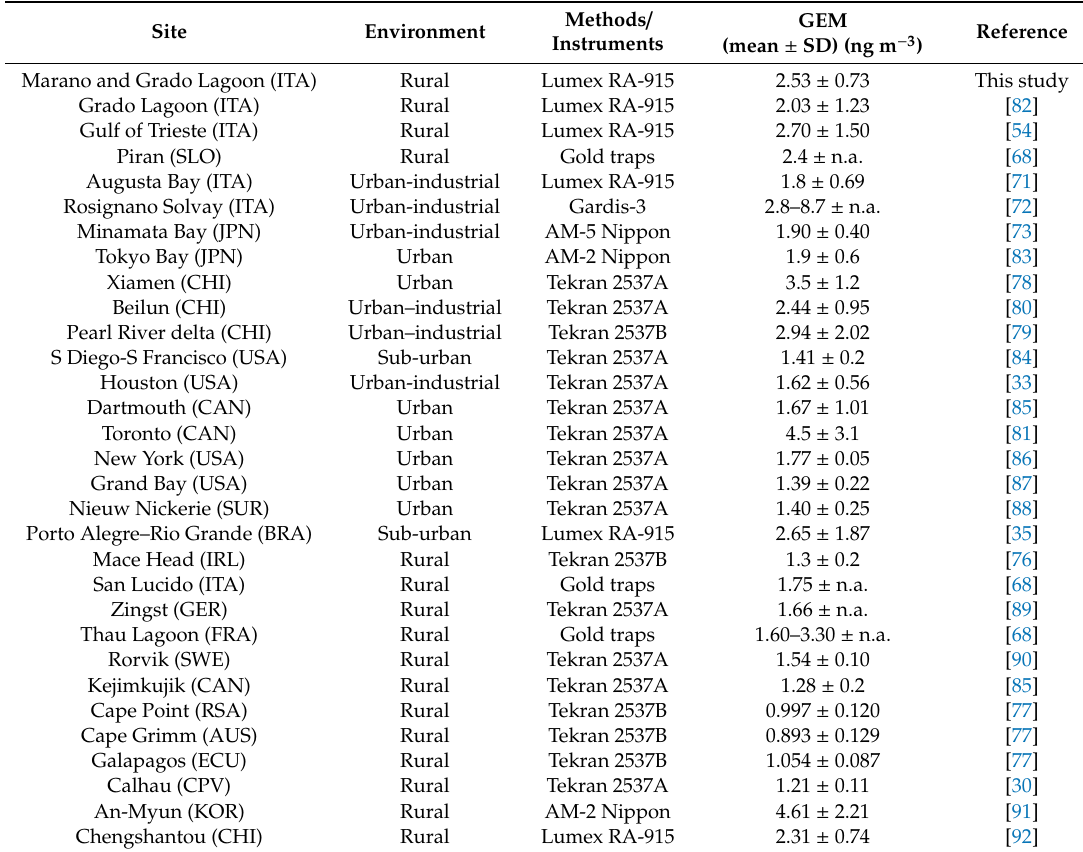
Table 2. GEM concentrations measured in the atmosphere in the Marano and Grado Lagoon compared to data found in the literature from other coastal environments. For a more detailed description on methods and averages refer to the original